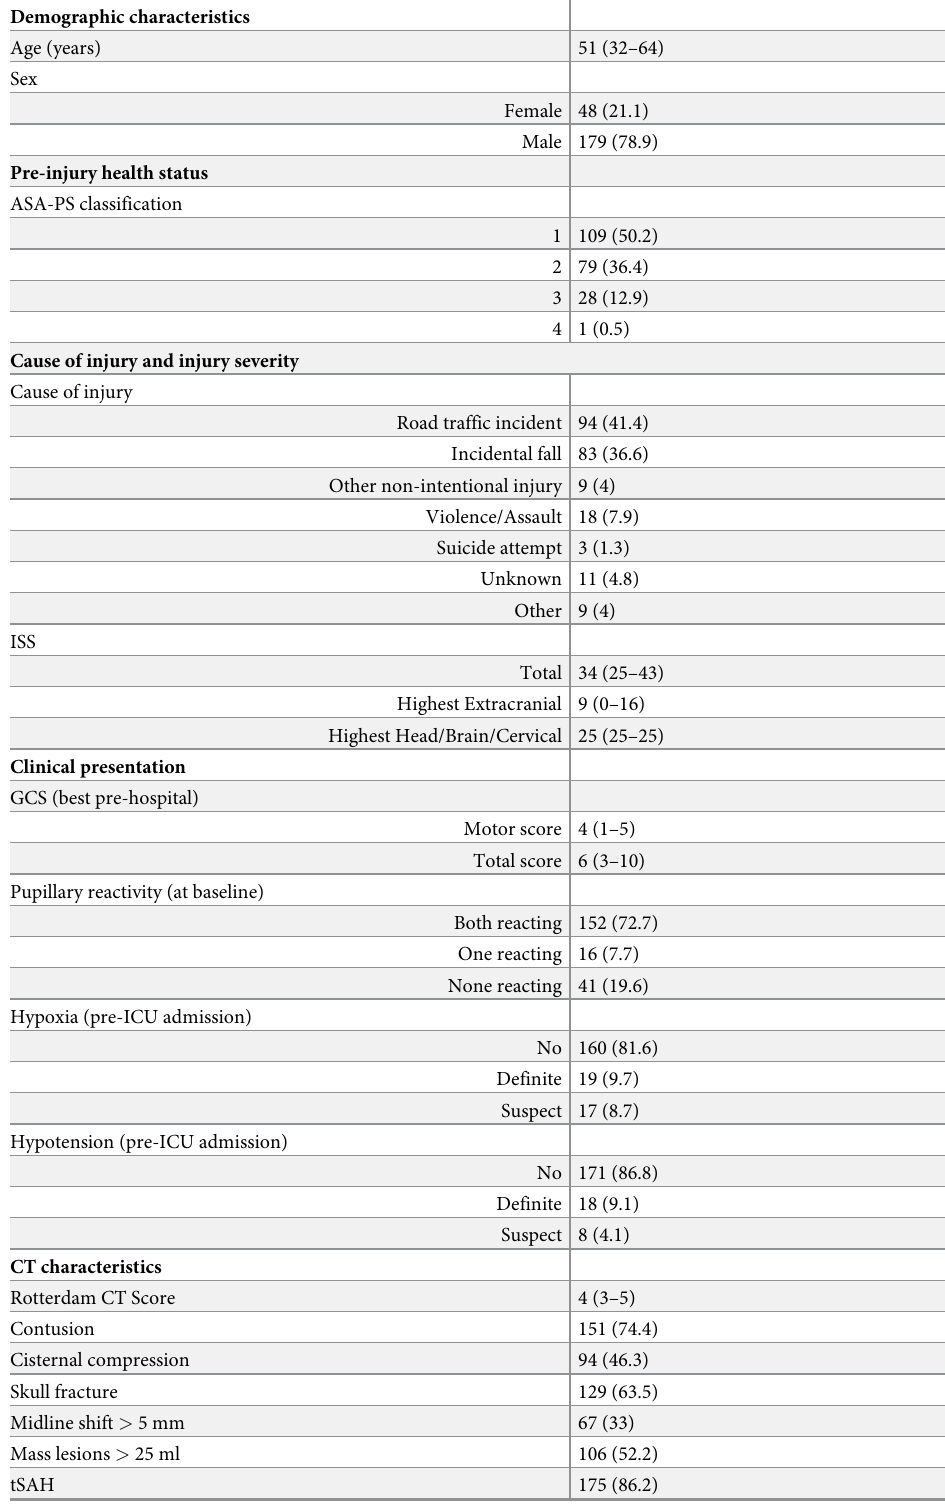
Table 1. Characteristics of the